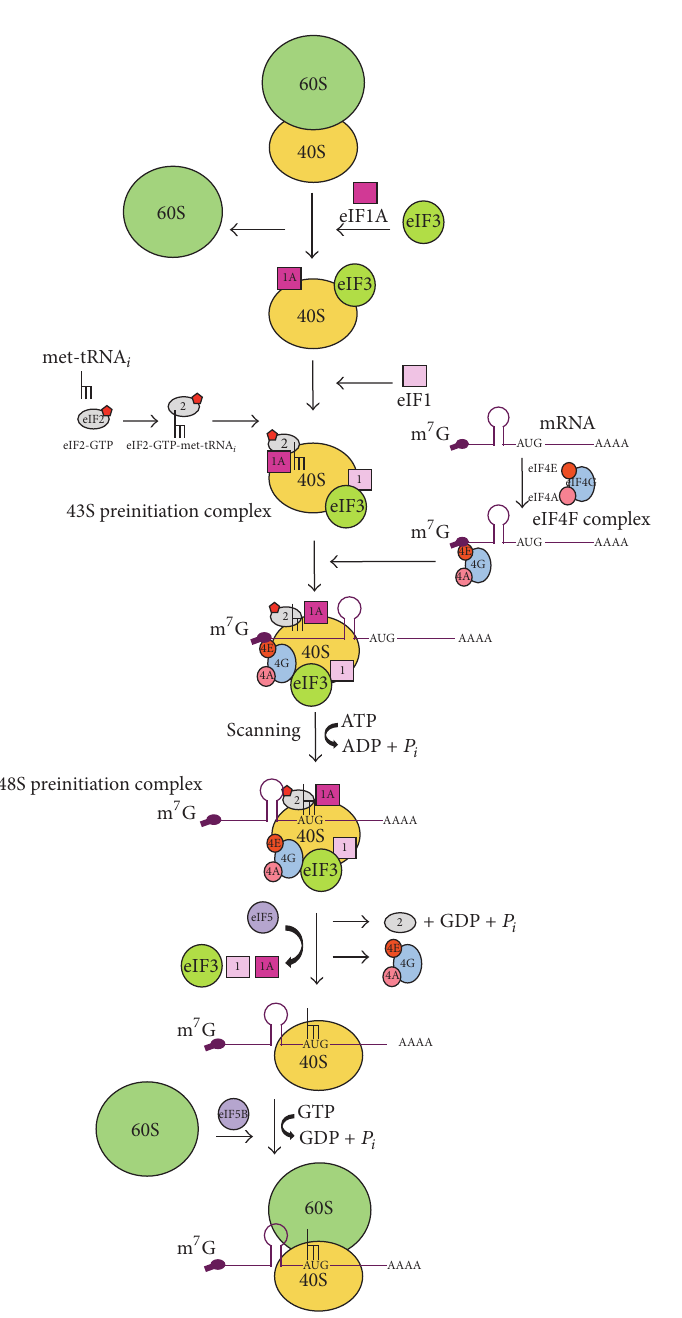
Figure 1: An overview of eukaryotic translation initiation. Most eukaryotic mRNAs contain a 5 󸀠 m 7 G cap which is bound by eukaryotic initiation factor 4F complex (eIF4E, eIF4G, and eIF4A). The 43S preinitiation ribosome complex which contains ternary complex (Tc) (eIF2- GTP-initiator tRNA) is recruited to the 5 󸀠 end of mRNAs via eIF3-eIF4G interaction. With the help of eIF4A (RNA helicase) the preinitiation complex is thought to scan mRNA until the start codon (AUG) is found. Subsequently, the 48S initiation complex is formed and Tc delivers tRNA into the P-site of the ribosome. Then, eIF5 binds to the 48S initiation complex and induces GTPase activity of eIF2 𝛼 . Upon GTP hydrolysis, all protein factors are released from the 40S ribosome subunit. Subsequently, eIF2 𝛼 is recharged with GTP by “GDP to GTP” exchange factor eIF2B. Finally, eIF5B unites the 60S and 40S ribosome subunits to form the 80S initiation complex and translation elongation